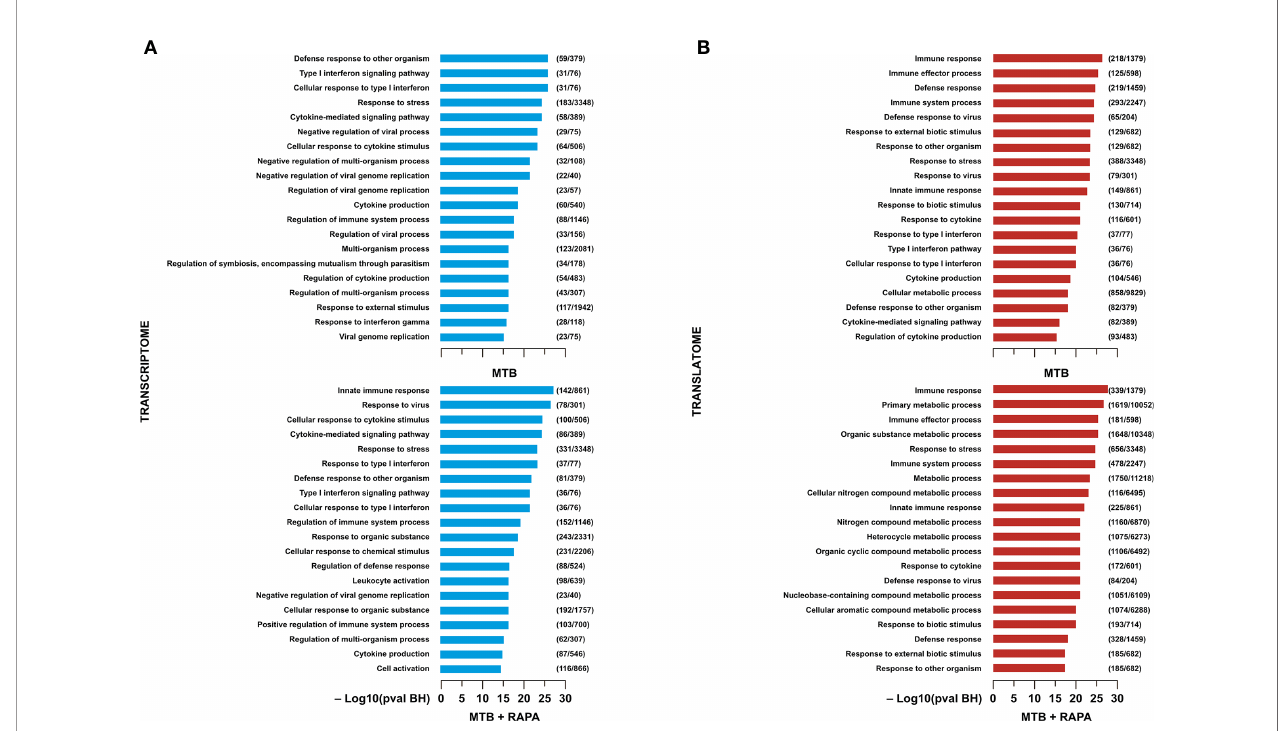
FIGURE 2 | Gene ontology analysis of genes regulated/modulated in transcriptome and in translatome of human DC infected with Mtb alone or in presence of rapamycin. Top 20 gene ontology (GO) terms within the biological process (BP) branch emerged from the list of genes found de-regulated (log2 FC > 1.5; FDR < 0.01) in transcriptome (A) (blue panels) and translatome (B) (red panels) of human DC infected with Mtb (MTB) and treated with rapamycin (MTB+RAPA). Relevant BP have been graphed by using the formula -log 10 of their Benjamini-Hochberg false discovery rate adjusted p-values. The numbers next to BP name, represent the total number of genes that may be signi fi cantly involved in the corresponding biological processes. The graph displays the classi fi cation term enrichment status and term